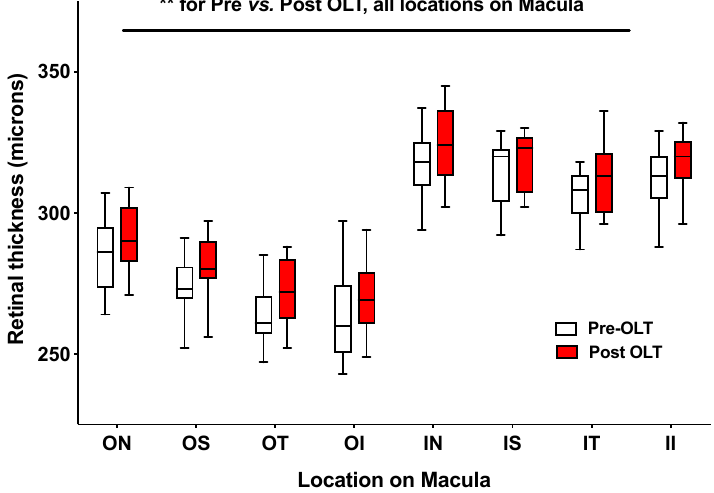
Figure 4. Box and whiskers plot of retinal thickness. Whiskers represent minimum and maximum. ** p ≤ 0.01; OLT, orthotopic liver transplant; ON, outer nasal, OS, outer superior; OT, outer temporal; OI, outer inferior; IN, inner nasal; IS, inner superior; IT, inner temporal; II, inner inferior.